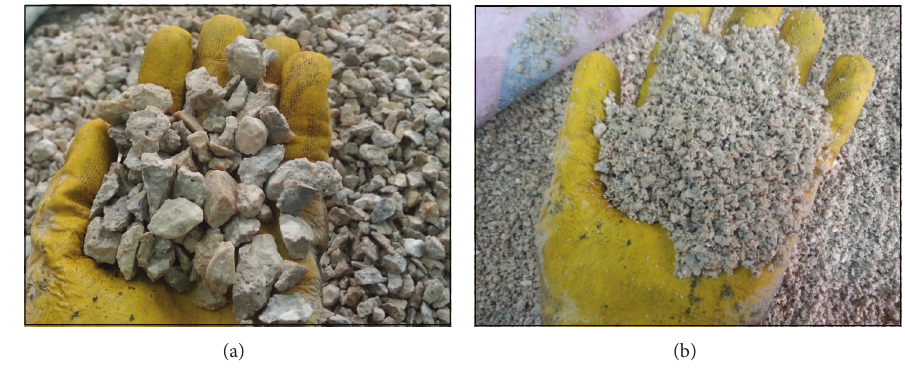
Figure 1: RAs: (a) RCAs and (b) RFAs as SSD